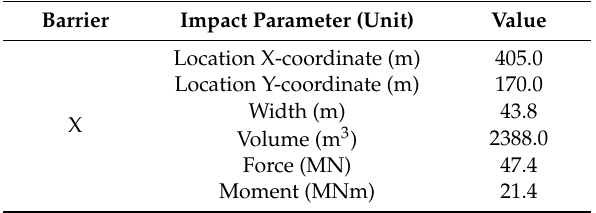
Table 2. The impact parameters from the collisions between the debris-flow and barrier.